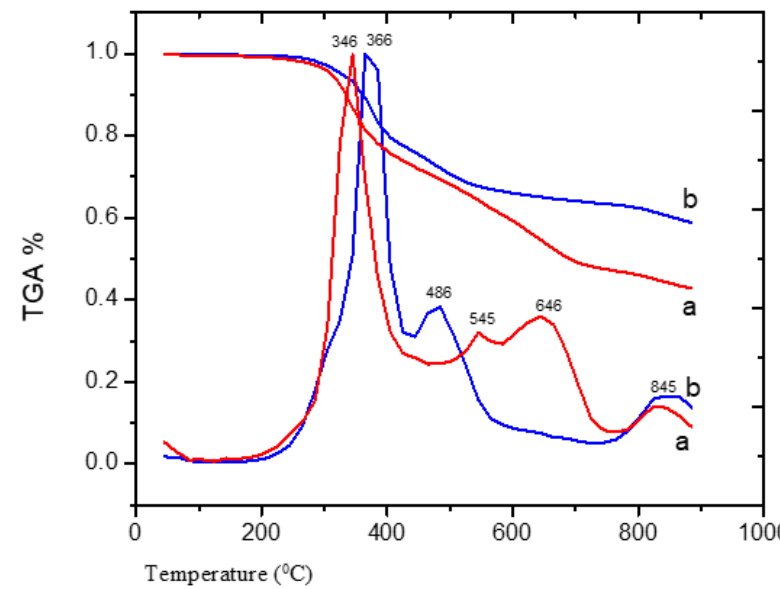
Figure 13. Thermogravimetric (TGA) curve of (a) adsorbent 1 and (b) adsorbent 2.